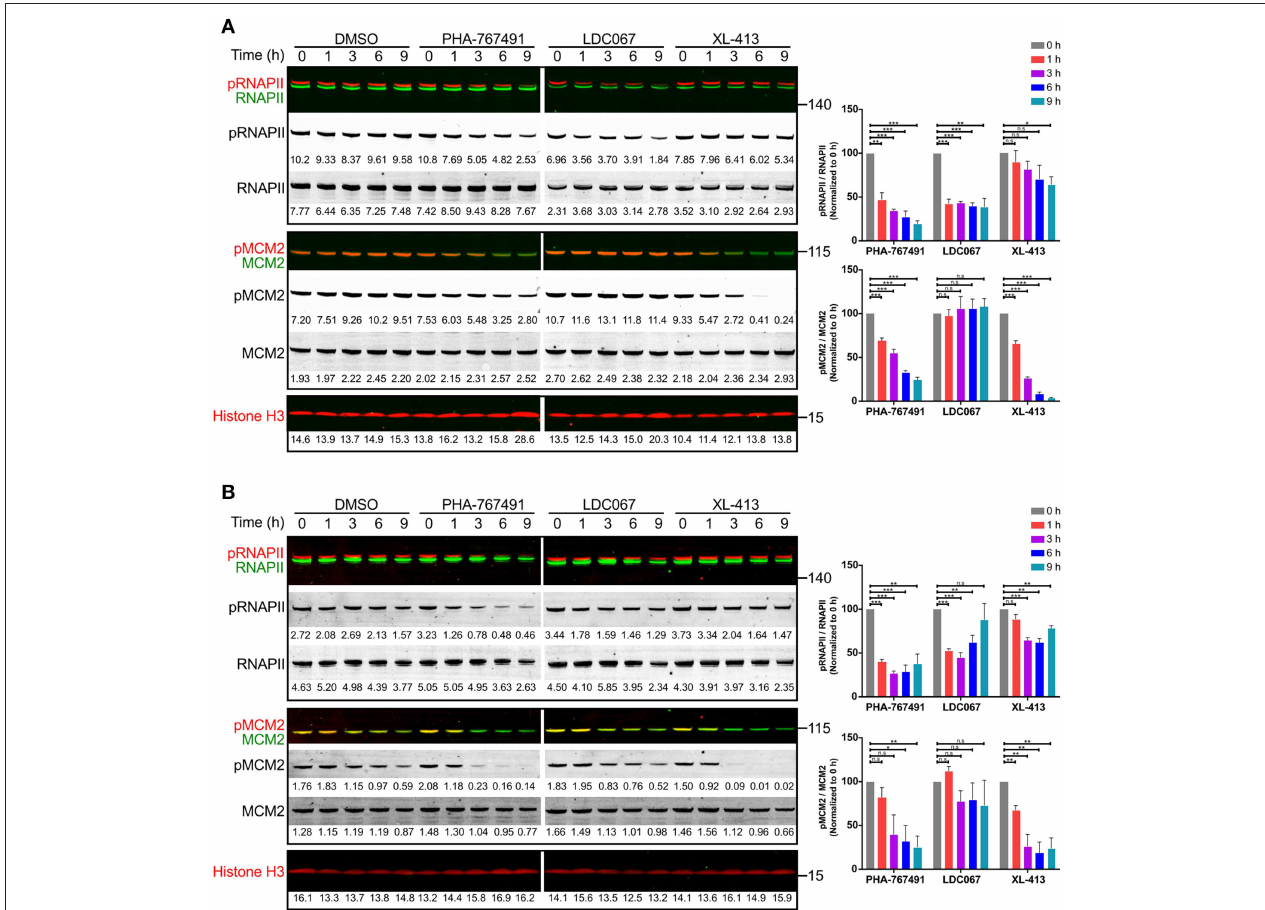
FIGURE 2 | PHA-767491 inhibits the function of canonical targets Cdc7 and Cdk9. PHA-767491 inhibits the phosphorylation of both RNAPII (S2) and MCM2 (S40) in (A) Jurkat cells and (B) OT-I CTL. The cells were incubated with the respective inhibitors for the indicated duration. Raw values for the band intensities are shown below the respective bands. Representative blots of three independent experiments are shown. The averaged values of the ratio of the band intensities for both RNAPII and MCM2, normalized to their respective 0h samples, are shown in bar charts to the right. Bar charts are represented as mean ± SEM. Statistical significance was determined by unpaired two-sided Student’s t -test (n.s, non-significant; * p < 0.05; ** p < 0.01; *** p <